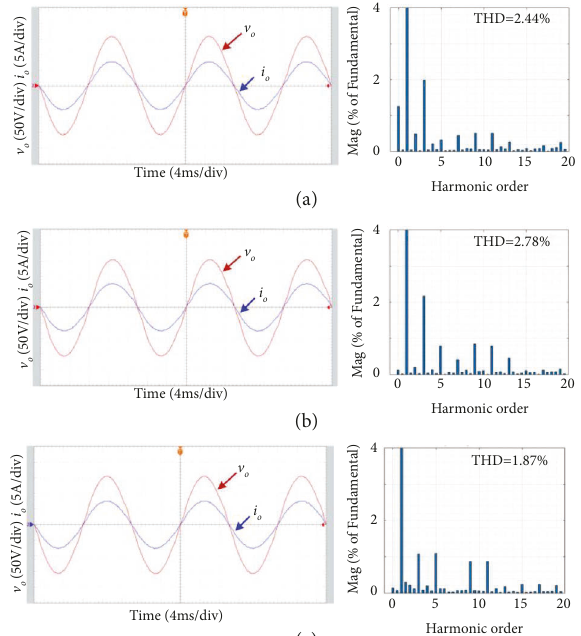
Figure 18: Steady-state waveforms of different control strategies under rated linear load (20 Ω ). (a) SRFPI, (b) LADRC, and (c) proposed SRFPI-LADRC.